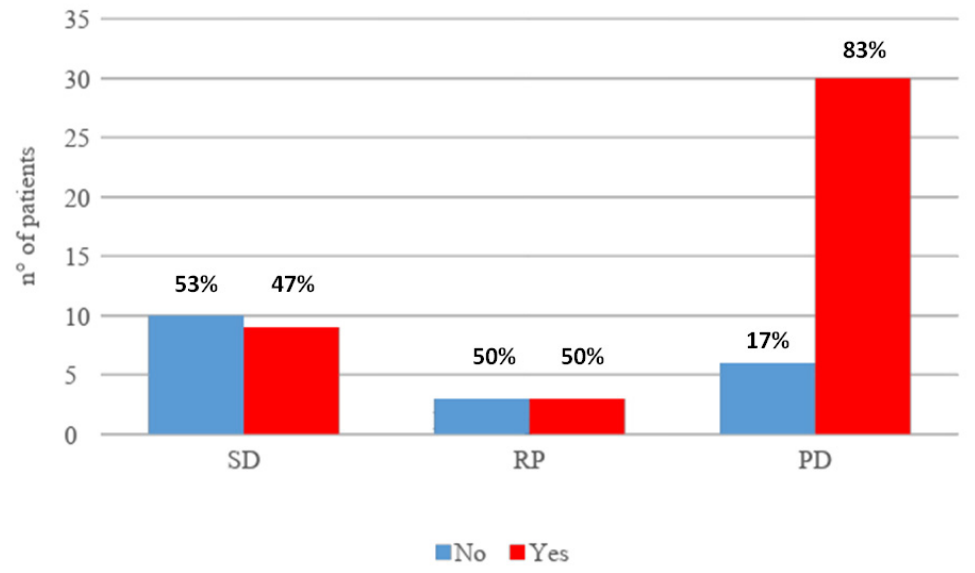
Figure 1. Association between response to immunotherapy and previous locoregional treatment. SD: stable disease; RP: partial response; PD: progressive disease.